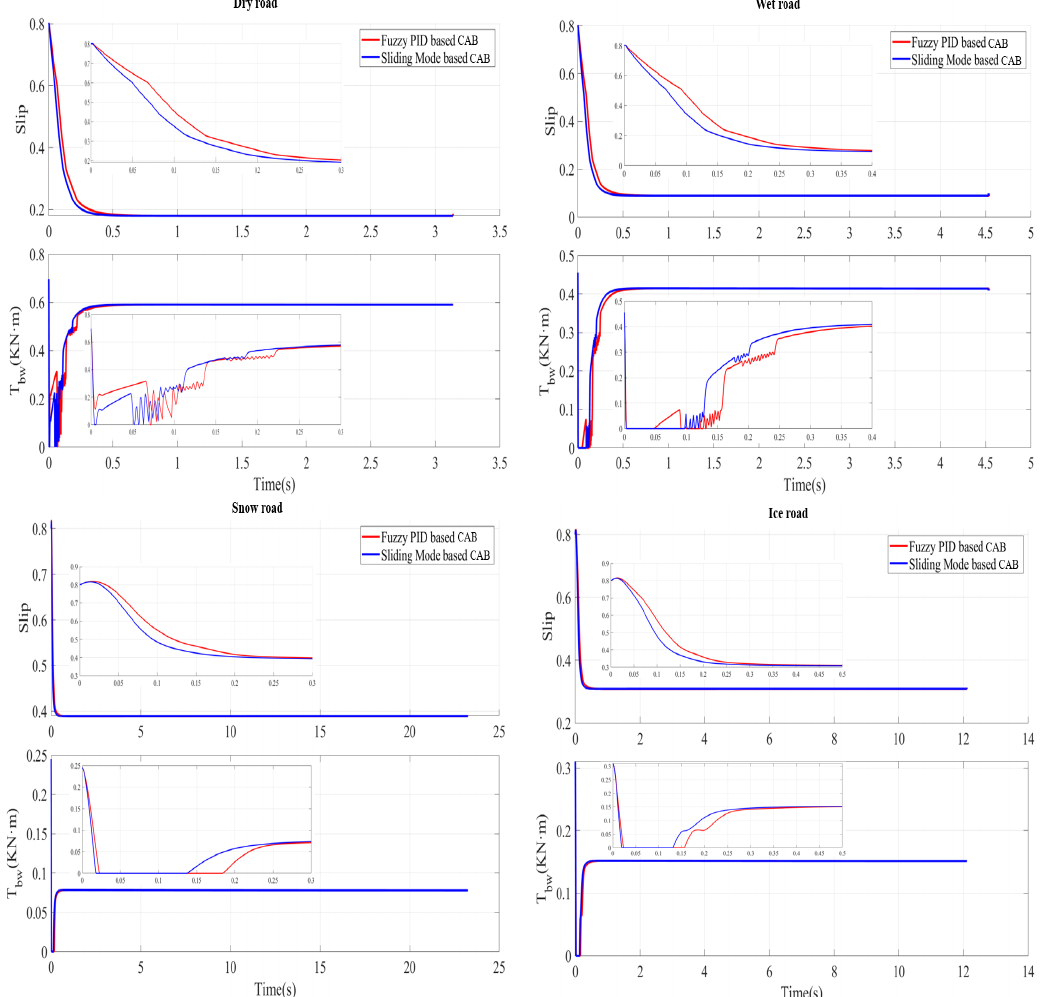
Figure 8. The whole sliding mode wheel slip ratio controller (SMWSC)-based braking process on different road conditions with v 0 = 100